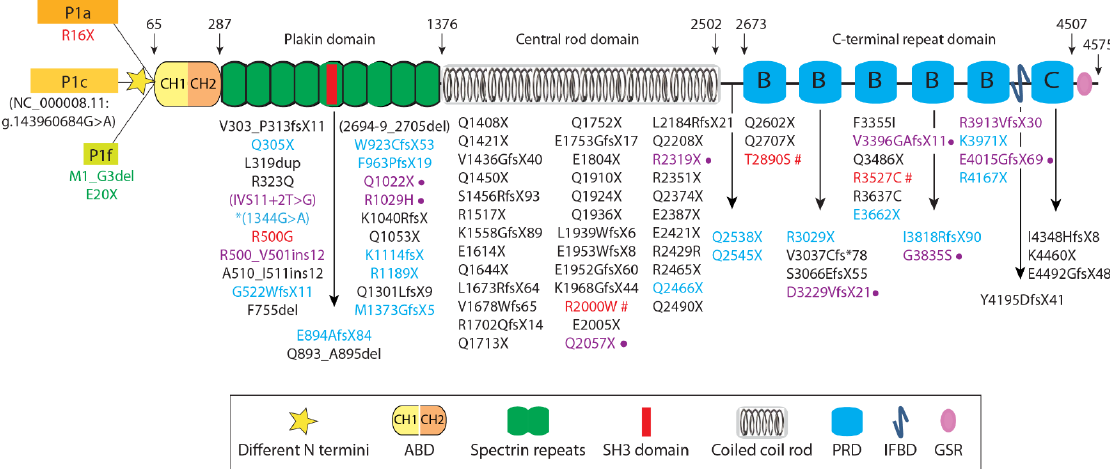
Figure 3. Schematic representation of the plectin molecule showing its structural organization and the localization of disease-causing mutations. The central α -helical rod domain, which forms a coiled-coil structure upon dimerization, and the subdomains of the flanking N- and C-terminal globular domains are indicated. Note that the plakin domain consists of 9 spectrin repeats with an SH3 domain embedded in repeat 5. The 6 plectin repeat domains at the C terminus are of the B and C type (for details see Introduction). Numbers above the molecule indicate the amino acid residue positions at the domain borders. ABD (actin binding domain), PRD (plectin repeat domain), IFBD (intermediate filament binding domain), GSR (Gly-Ser-Arg repeats). Plectin mutations are annotated according to the convection “Mutations in the plectin gene related to human diseases should be named based on the position in NM_000445 (variant 1, isoform 1c), unless the mutation is located within one of the other alternative first exons, in which case the position in the respective Reference Sequence should be used (provided by RefSeq, August 2011)” even when this was not followed in the original publication. Mutations causing epidermolysis bullosa (EBS) with muscular dystrophy (EBS-MD) are listed in black, EBS with pyloric atresia (EBS-PA) in blue, EBS with limb-girdle muscular dystrophy (EBS-LGMD) in magenta, and EBS-MD with congenital myasthenic syndrome (EBS-MD-Mys) in magenta followed by a dot, LGMD autosomal recessive 17 (LGMDR17) in green, EBS and EBS-Ogna in red, the hashtag indicates autosomal dominant.